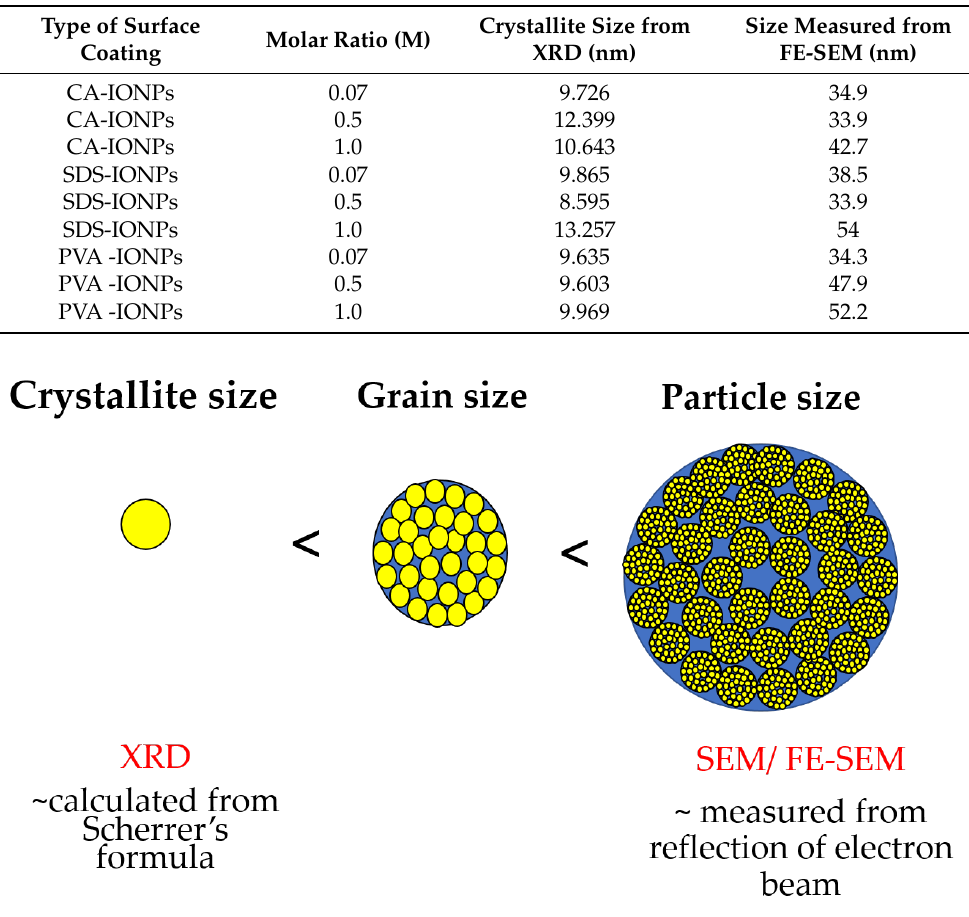
Figure 4. Comparison between crystallite, grain and particle size. Table 1. List of surface-coated iron oxide nanoparticles with their respective crystallite sizes.